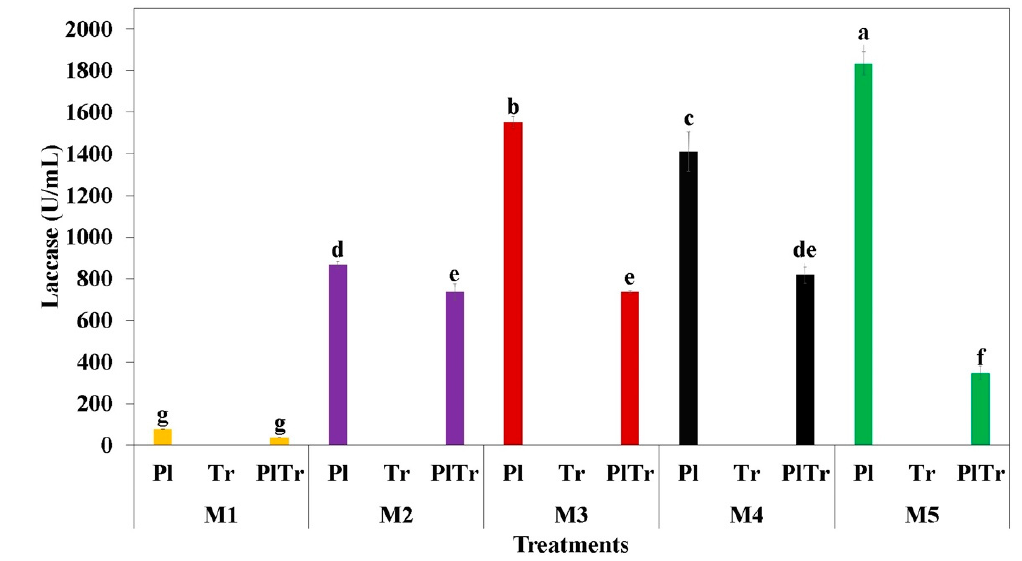
Figure 5. Enzymatic activities of laccase obtained in submerged fermentation using the media M1, M2, M3, M4 and M5, which contains oil palm decanter cake (OPDC), wheat bran (WB) or/and cottonseed cake (CSC) as substrate. Legends: P. lecomtei monoculture (Pl), T. reesei monoculture (Tr) and P. lecomtei + T. reesei co-culture (PlTr). Different letters over the bars mean significant differences ( p < 0.05) according to the Tukey test.